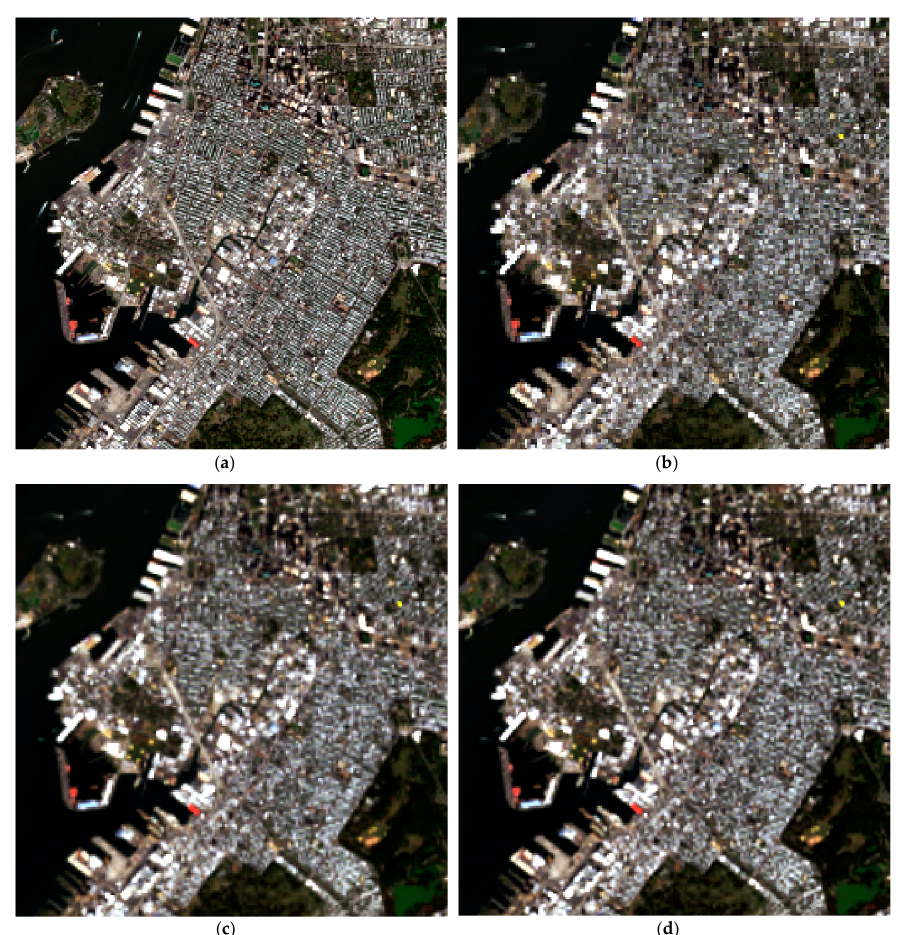
Figure 3. New York 256 × 256 20-m pixel true color subsets: ( a ) Sentinel-2A 20-m red, green, blue bands aggregated from the original Sentinel-2A 10-m bands; ( b ) Landsat-8 20-m red, green, blue bands nearest neighbor resampled from 30 m; ( c ) Landsat-8 20-m red, green, blue bands bilinear resampled from 30 m; and ( d ) Landsat-8 20-m red, green, blue bands cubic convolution resampled from 30 m.